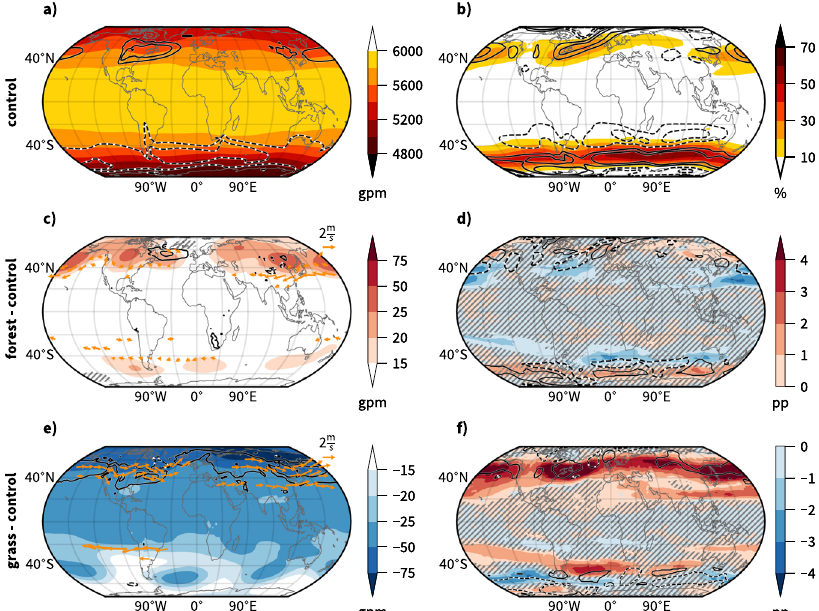
Fig. 4 | Changes in the extratropical atmospheric circulation. a Annual mean geopotentialheightat500hPa(Z500,shading,ingpm)andmeridionalcomponent of the eddy heat fl ux at 850hPa ( v 0 T 0 , contours, − 15, − 10, 10, and 15Kms − 1 ) in simulation control , b annual mean frequencies of deep jets (shading, in %) and E-vectordivergence(contours, − 3, − 1.5,1.5and3m 2 s − 2 (100km − 1 ), c , e differencesin annualmeanZ500(shading,ingpm),eddyheat fl uxat850hPa(contours, − 3, − 1,1, and3Kms − 1 ),andrepresentativewinddifferencesat300hPa(arrows,onlythesixty globally largest differences at every tenth latitude and longitude index are shown, i.e., if larger than 0.6ms − 1 for forest and 0.6ms − 1 1.4ms − 1 int grass ) for c for- est minus control and e grass minus control , and d , f differences of annual mean